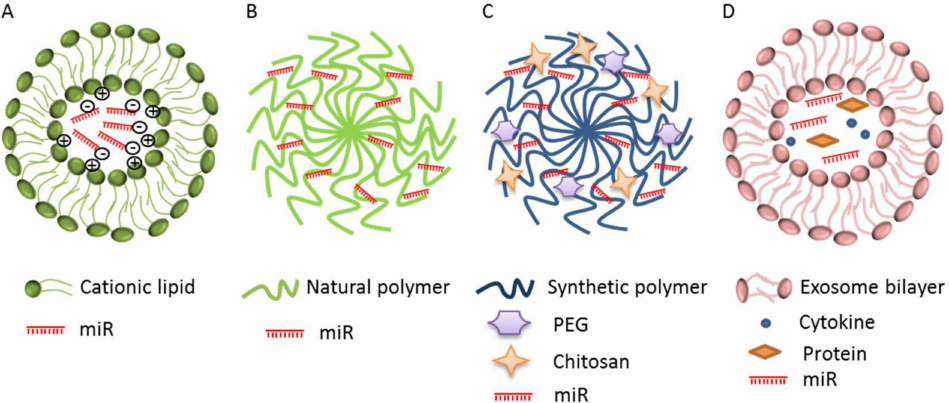
Figure 2. Schematic illustration of miRs delivery system. ( A ) Lipid-based carriers or cationic liposomes include monovalent and multivalent lipids; ( B , C ) polymer-based carriers include natural (green) and synthetic (blue) polymers conjugated with polyethylenglycol (PEG) and chitosan; ( D ) exosomes that vehicle miR, other nucleic acids (mRNA, lncRNA), cytokines, and